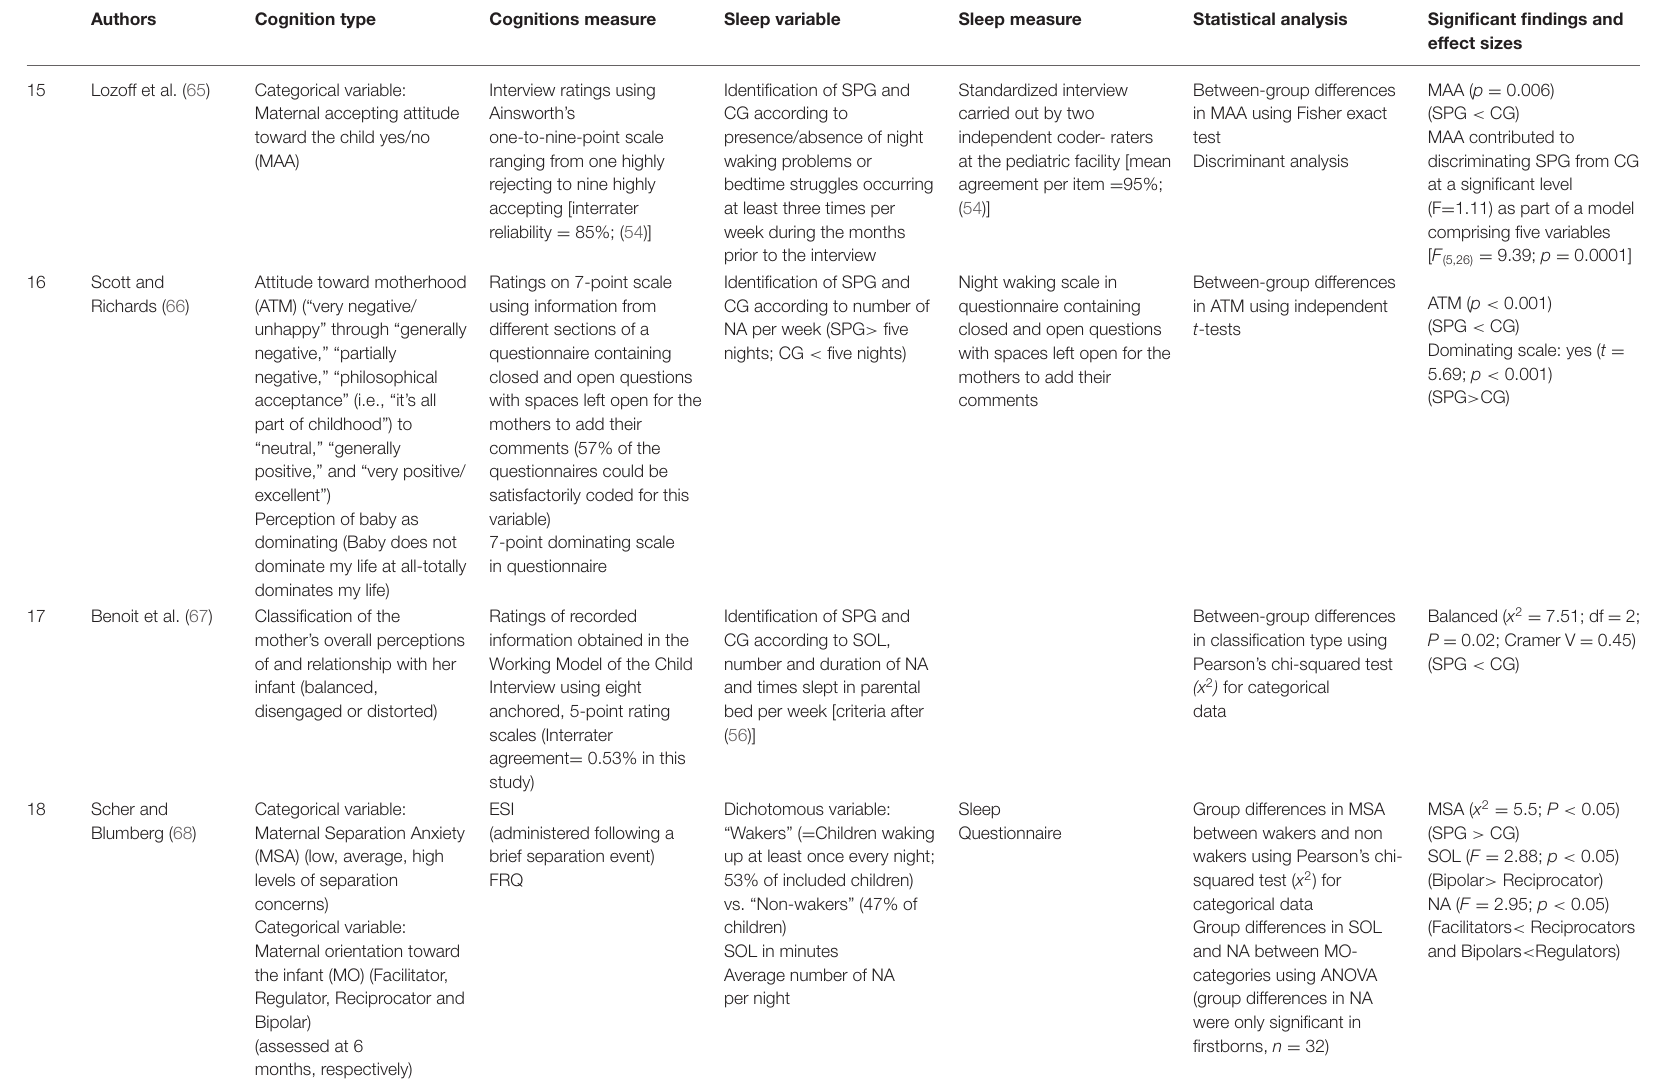
TABLE 2 | Studies on child-related cognitions not referring to